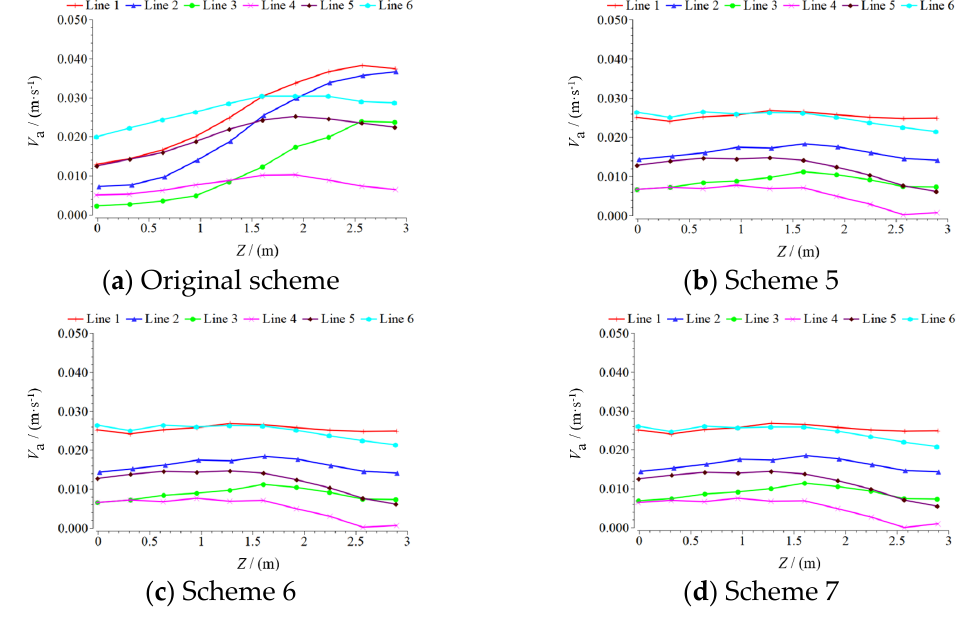
Figure 14. Diagram of axial velocity on the inlet of the sump 2#.